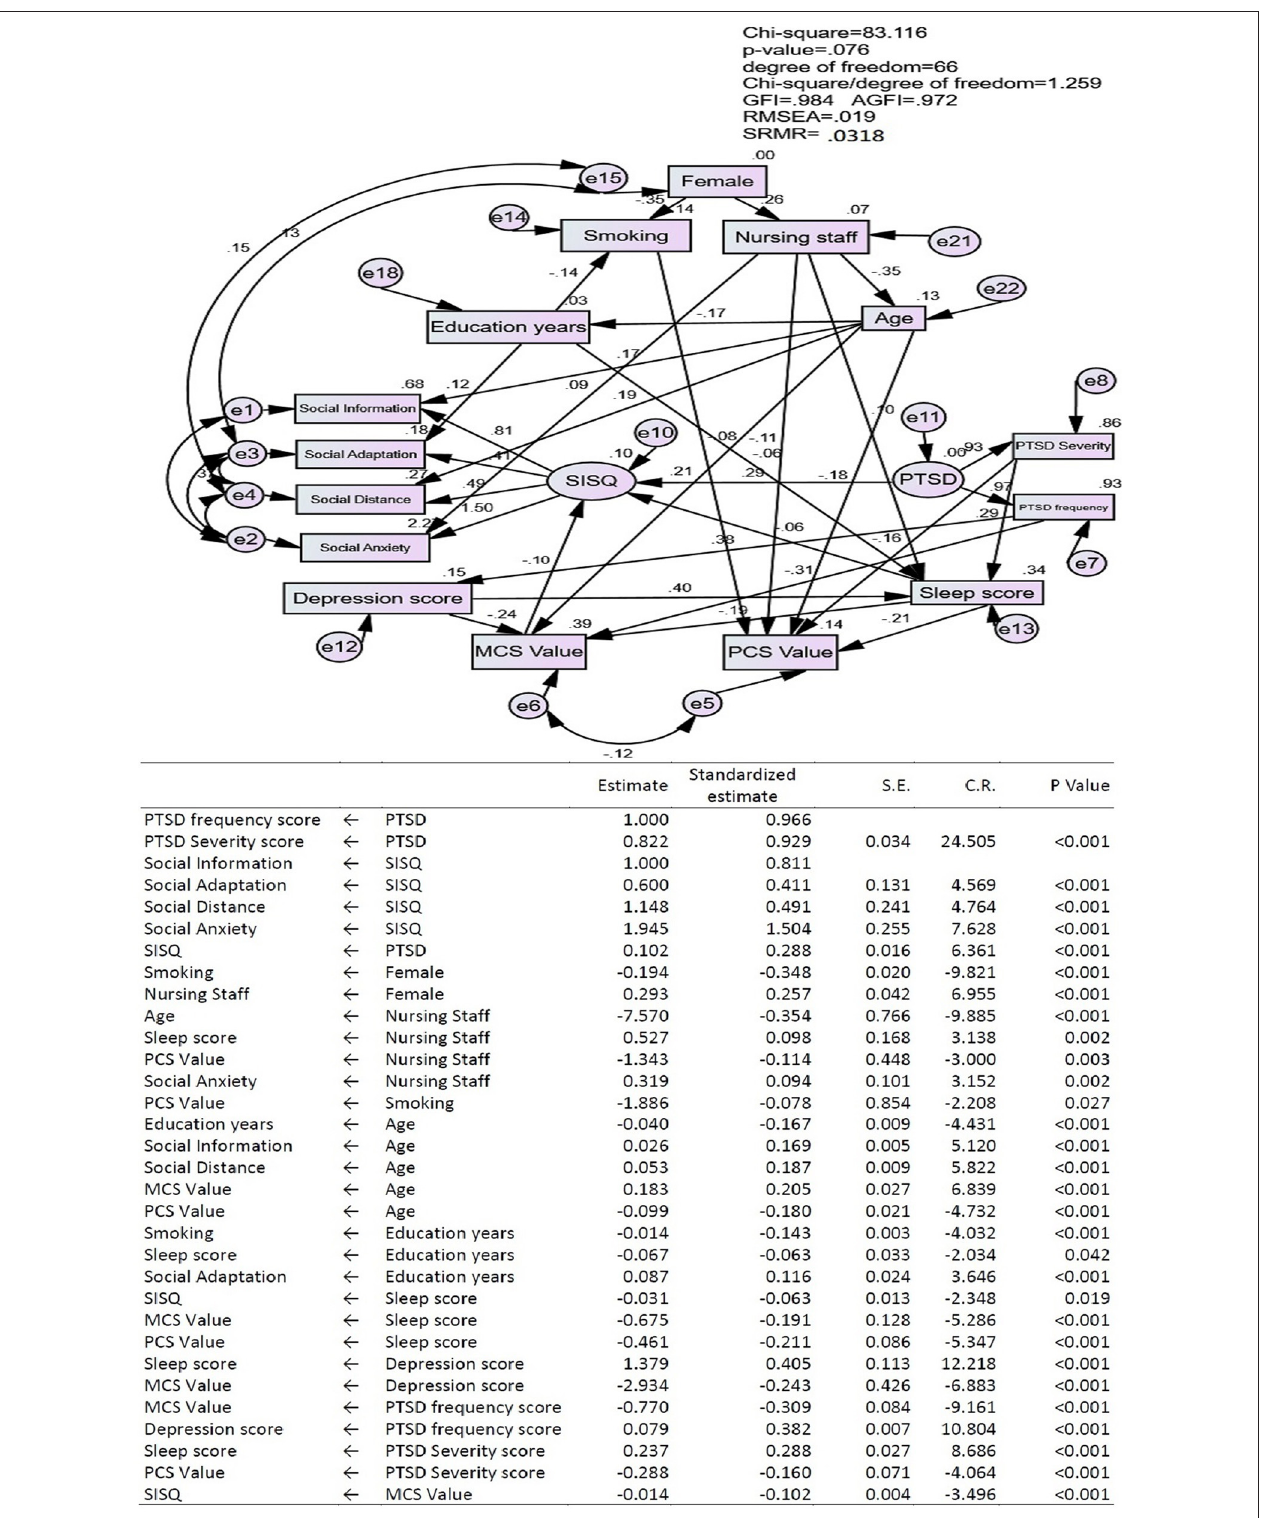
FIGURE 1 | The conceptual model showing interrelationships between Societal Influences Survey Questionnaire (SISQ), mental component summary (MCS) value, and physical component summary (PCS) value of Short form-12 items health survey (SF-12v2), PTSD, Age, Sleep score, depression score, Nursing Staff, gender, education years, and